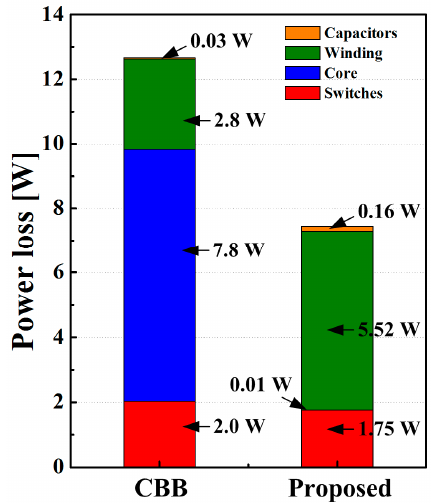
Figure 20. Results of loss analysis for the conventional and proposed CBB BDCs operating at V a = 48 V, V b = 60 V, and P b = 500 W.